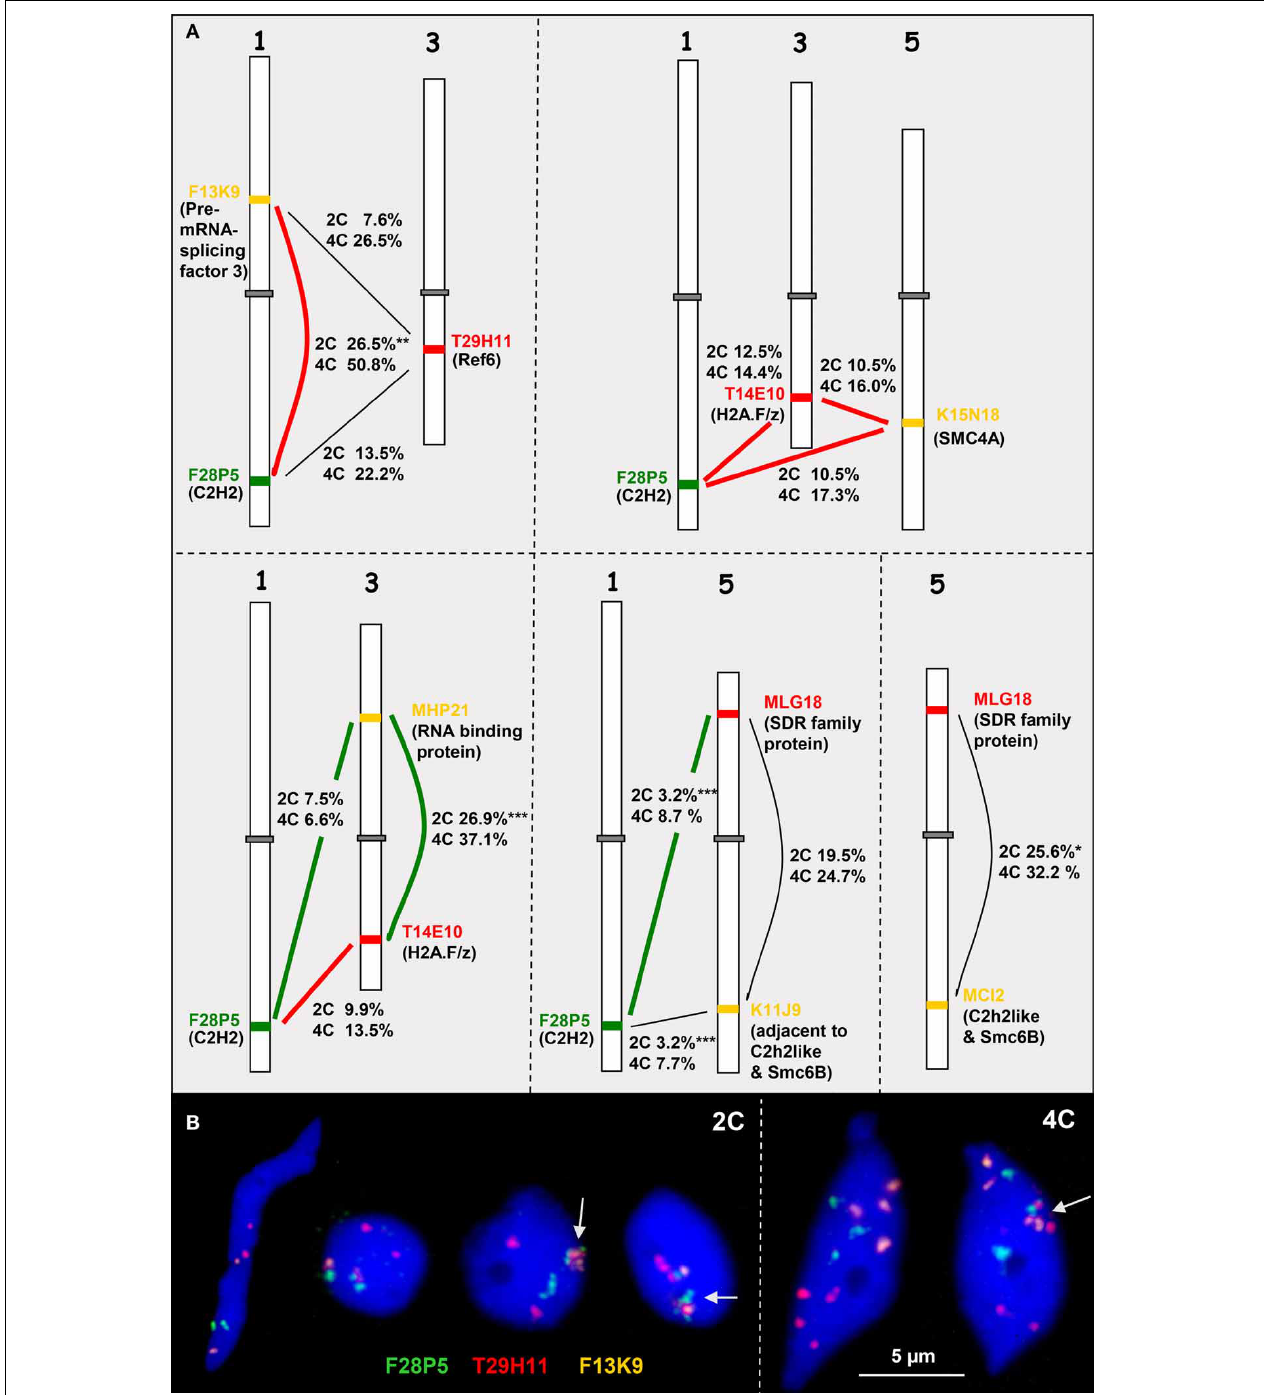
FIGURE 5 | Heterologous associations in cis and trans. (A) Schemes of chromosomes 1, 3, and 5 showing euchromatin segments (probed by BACs) containing high (connected by bold red lines) or low (bold green lines) co-expressing genes (encoded proteins in parentheses). The percentage of association in cis or trans in 2C and 4C nuclei is indicated (for number of nuclei analyzed see Table S3). The thin black lines indicate combinations with missing co-expression data. (B)